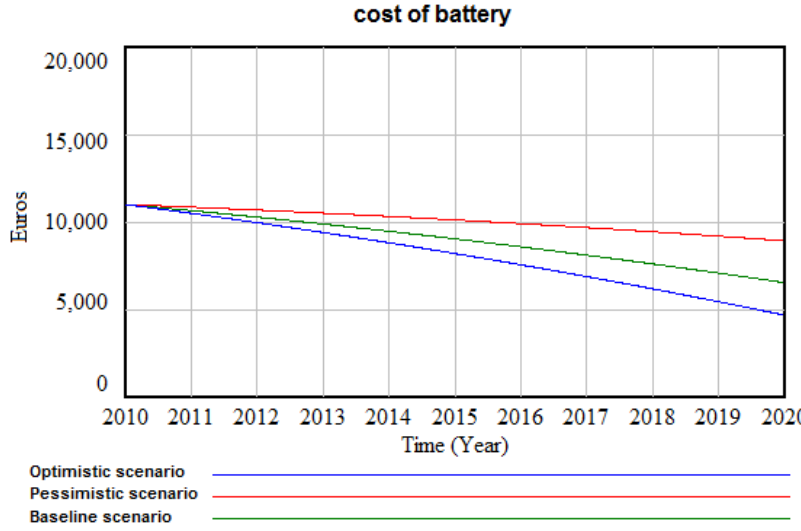
Figure 11. Forecast of battery cost in the optimistic, pessimistic and baseline scenarios (own calculations).